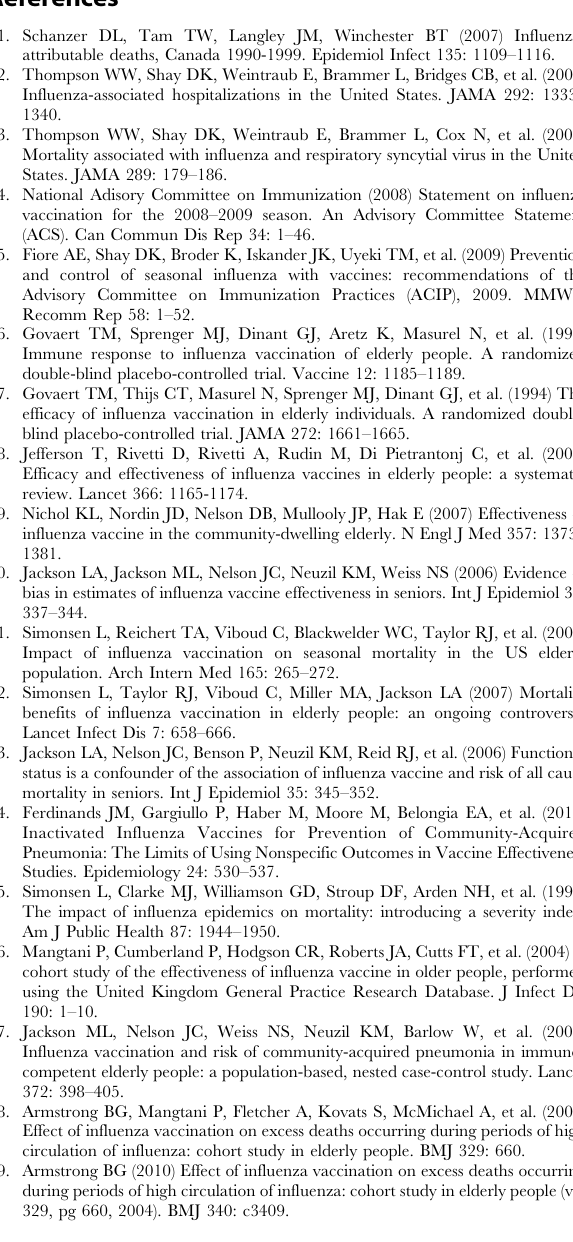
Table S3 Number of individuals, vaccinations and outcomes for each study year, stratified by age